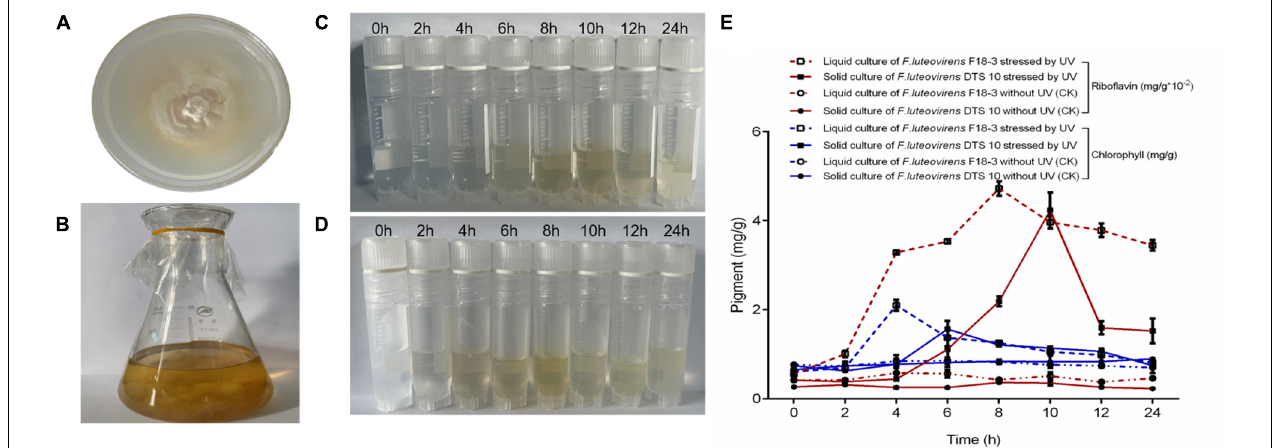
FIGURE 6 | Riboflavin and chlorophyll induced by UV of F. luteovirens in mycelium. (A) Plate culture of F. luteovirens F18-3. (B) Liquid culture of F. luteovirens DTS10. (C) Abstracted riboflavin of F. luteovirens F18-3 in mycelium stressed by UV in solid culture. (D) Abstracted riboflavin of F. luteovirens DTS10 in mycelium stressed by